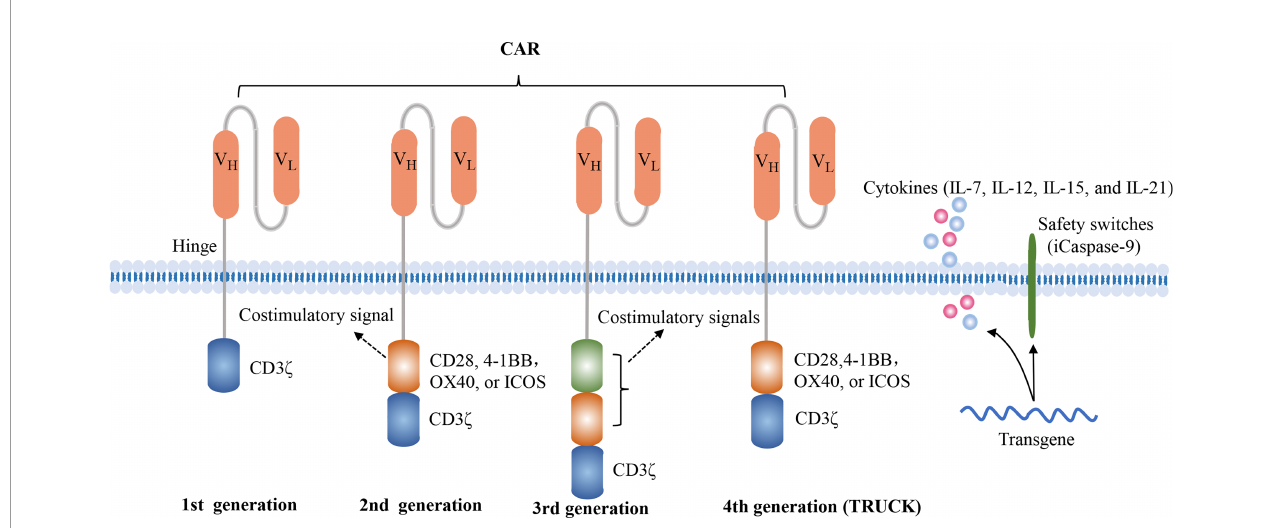
FIGURE 1 | Four generations of CAR constructs. The fi rst-generation of CAR consists of the antigen recognition domain scFv and an intracellular T cell activation domain CD3 z . The second-generation CAR adds a costimulatory molecule, such as CD28, 4-1BB, OX40 or ICOS, which enables the T cells to obtain a superior proliferative capacity and secrete large amounts of cytokines. The third-generation CAR contains two distinct costimulatory domains, such as CD28 and 4-1BB. The fourth-generation of CAR, also known as TRUCK or armored CAR, is additionally equipped with safety switches or engineered to secrete cytokines in order to regulate the persistence or the function of CAR-T cells, such as iCaspase-9, IL-7, IL-15,